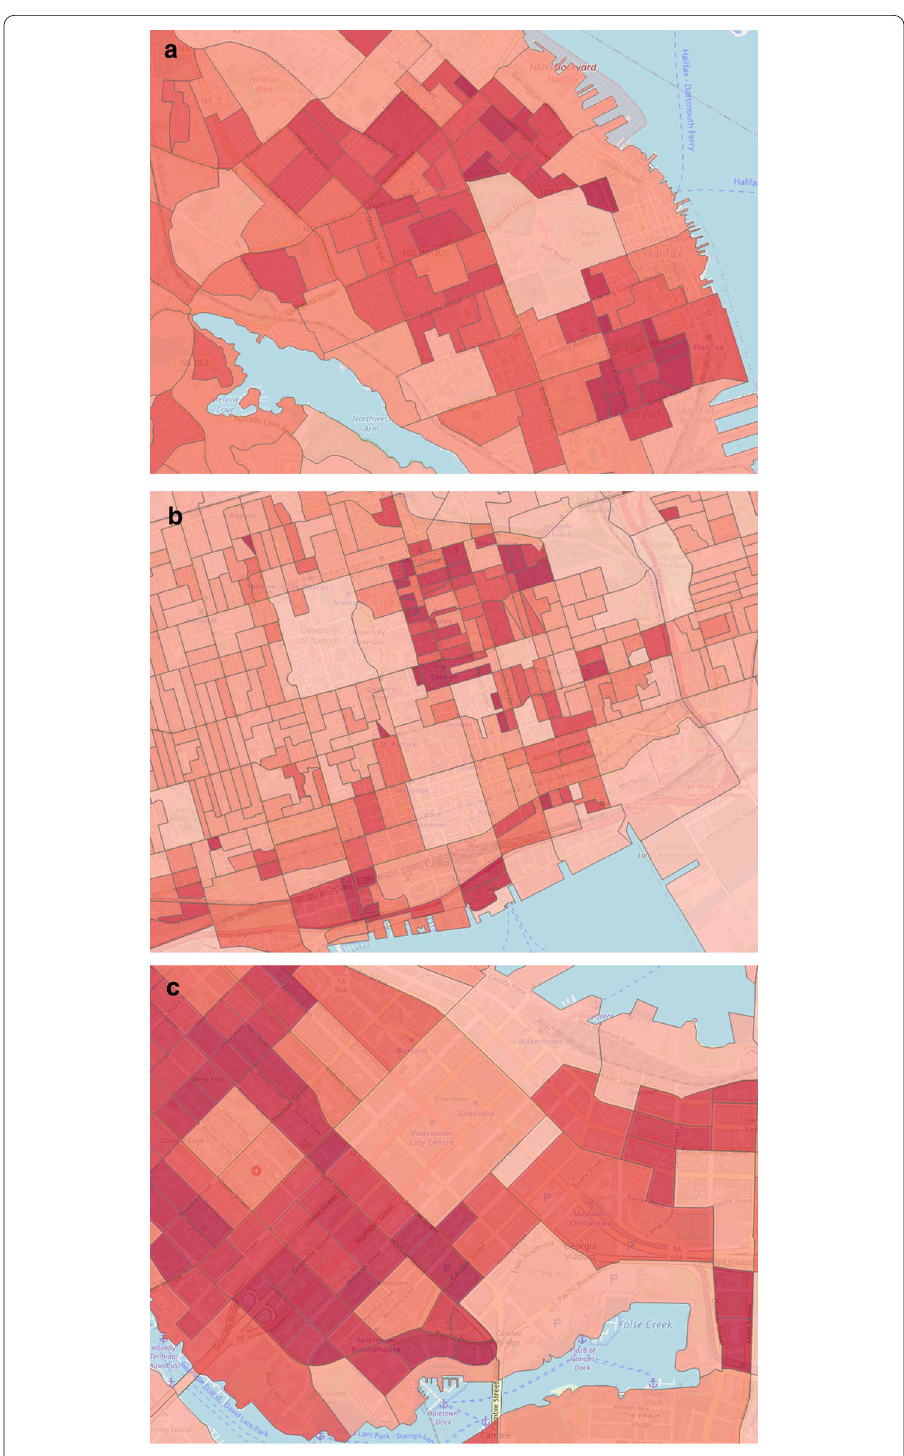
Fig. 4 Population densities focusing on downtown areas for a Halifax, b Toronto and c Vancouver cities. The bin size for all three images is 100. The dark red color indicates high concentrated area and light red indicates the